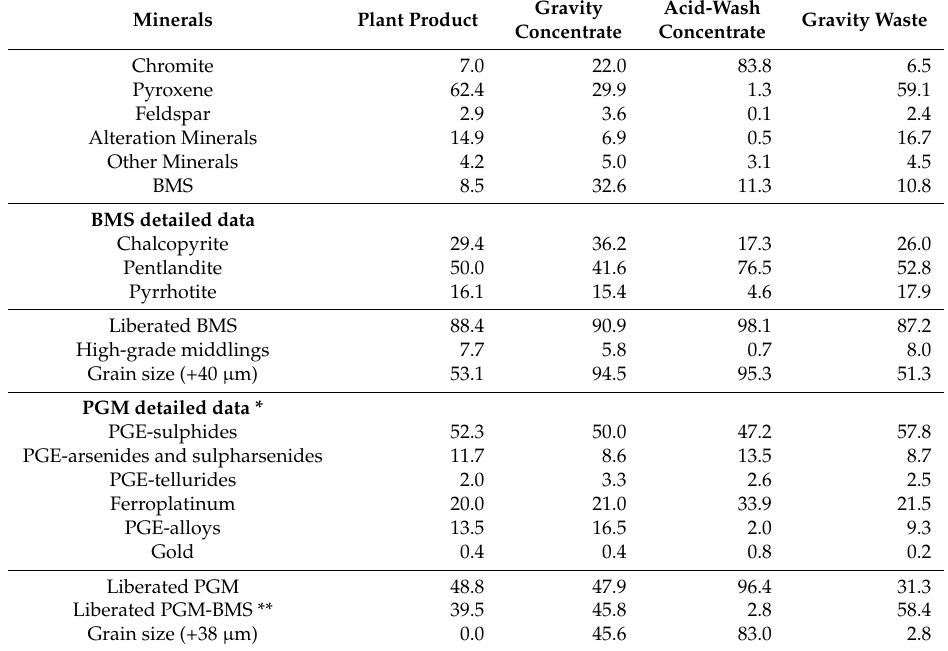
Table 4. Mineralogical data of the UG-2 plant product (low sulphide content). All values in per cent as determined by QEMSCAN (gangue mineral and sulphide data) and MLA (PGM data).